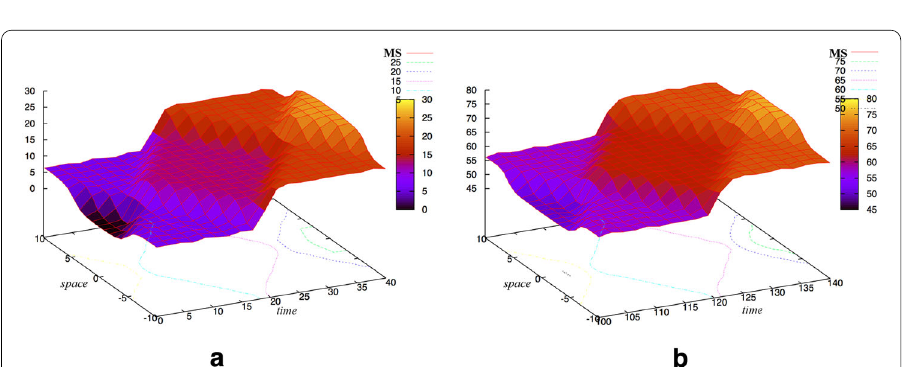
Fig. 12 Approximate solutions for t ∈ [0;500], with (cid:7) t = 5 . 10 − 2 , (cid:7) x = 5 . 10 − 2 . a Energy conserving scheme. b Multisymplectic scheme